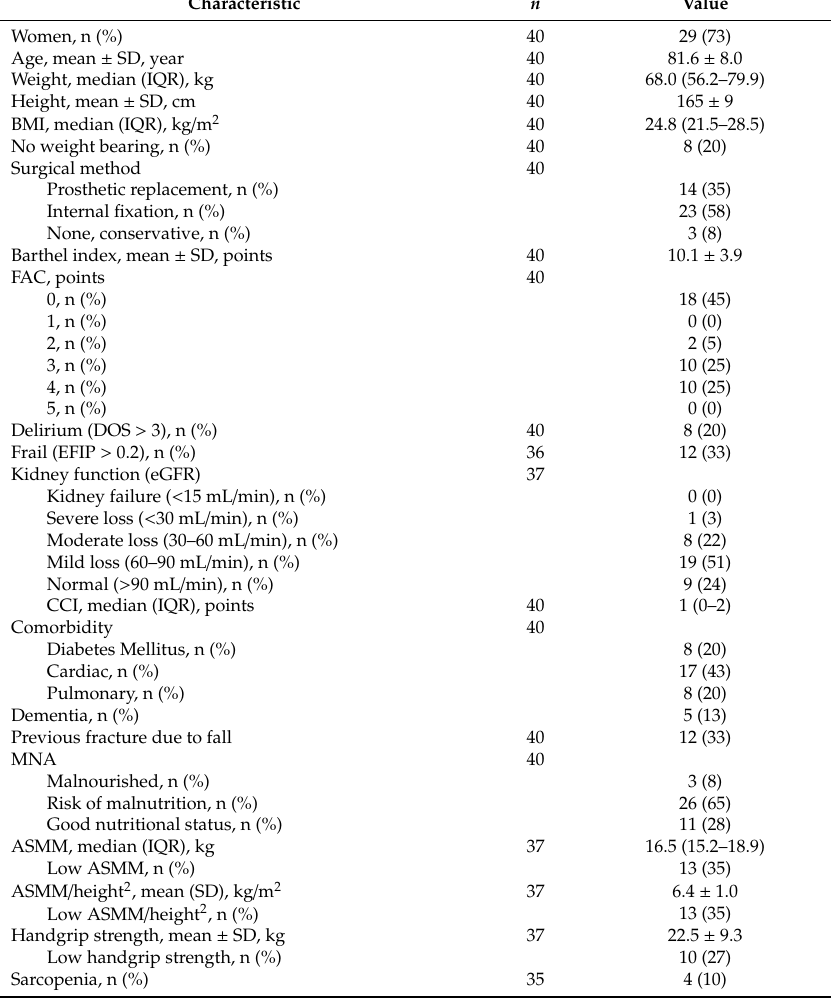
Table 1. Characteristics of the hip fracture